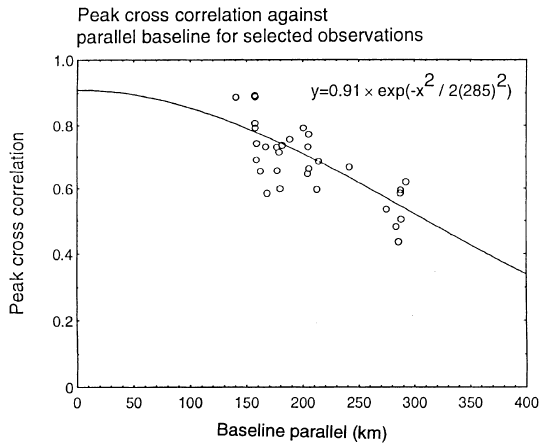
Fig. 3. The fall in maximum correlation coe(cid:129)cient as the parallel baseline increases. In this figure only high-latitude observations in which the fast-stream was >85% dominant are shown. A Gaussian curve is fitted which gave the best least-squares fit out of a straight line, and exponential decay curve and a Gaussian